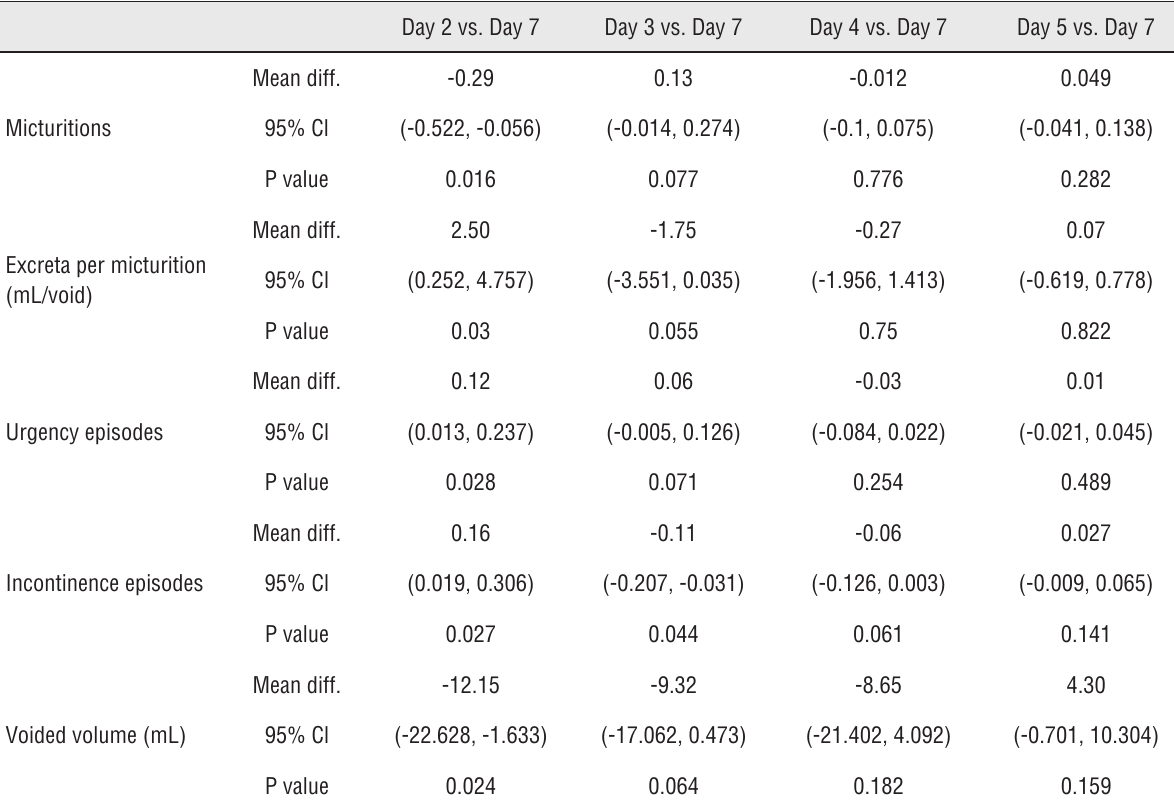
Table 3-Results of the comparisons between different diary’s length (comparison day1 versus day 7 and day 6 versus day 7 were omitted from the Table). Mean difference, 95% confidence intervals and p value of each comparison are